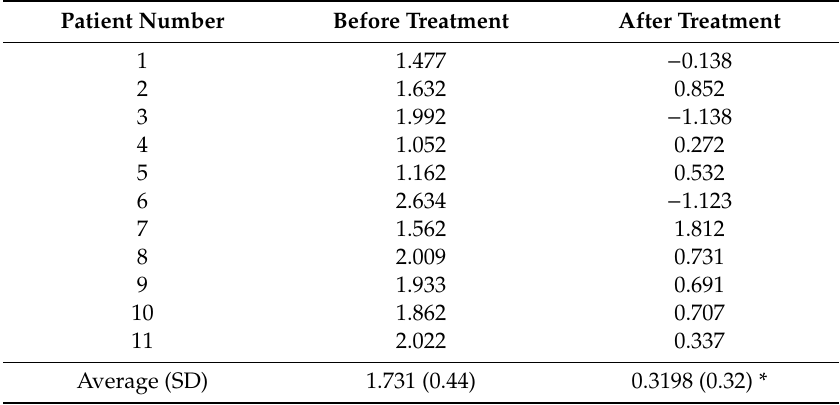
Table 3. Total discriminant function (TDF) score for each subject before and after two months of agmatine sulfate treatment, also showing average